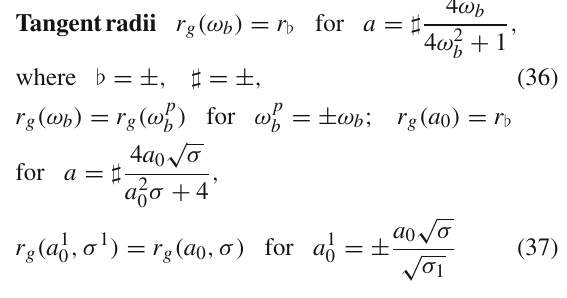
/ a √ 0 for 0 σ for equal (ω ) of Eq. (35) for b b